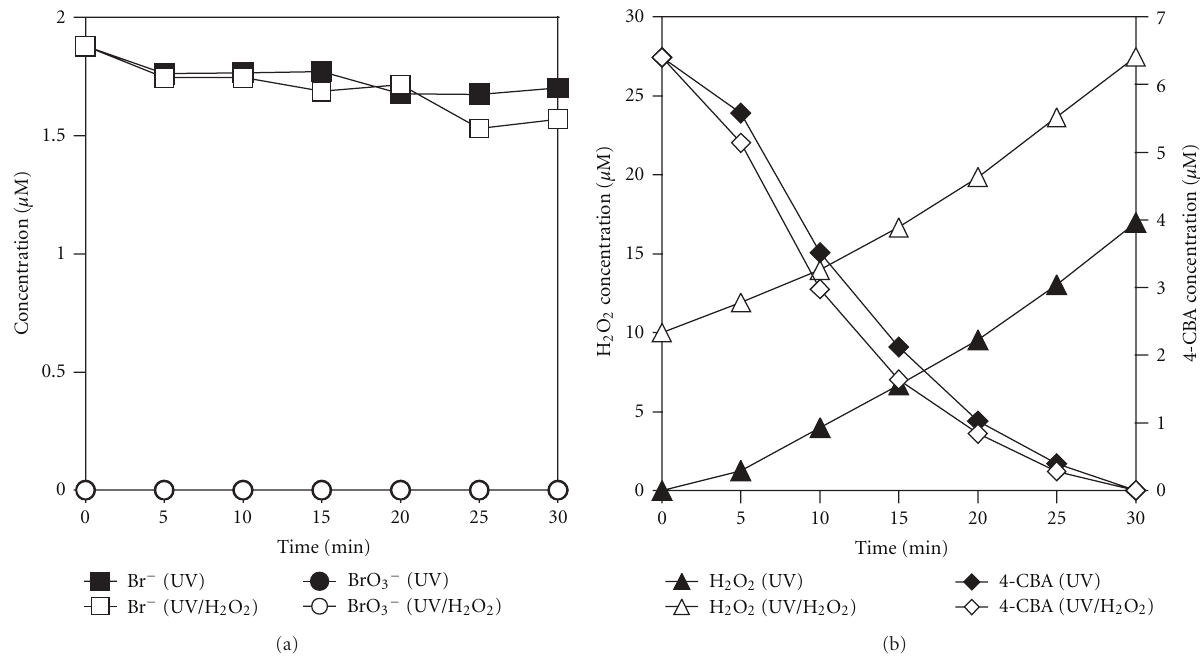
Figure 2: Changes in concentrations of Br − , BrO 3 − , H 2 O 2 , and 4-CBA during UV irradiation (UV) and UV/H 2 O 2 treatment at neutral pH. The initial H 2 O 2 concentration for UV/H 2 O 2 was 10 µ M.